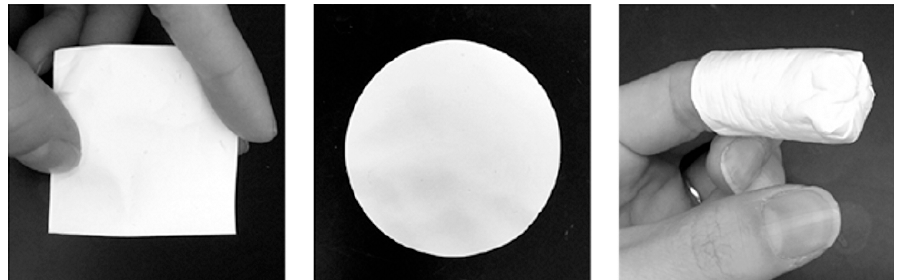
Figure 5. Examples of differently shaped, human sized PVA nanofiber mats (fiber cross-section diameter of ≈ 200–300 nm and mat thickness of 50–220 µ m according to Krogstad et al. [119]). Left —square (25 cm 2 ); center —circle (diameter = 5 cm); right —capped tube (length = 4 cm, diameter = 2 cm). Adapted from [118] under the terms of the Creative Commons Attribution License 4.0 (Copyright 2018 Laborde et al.; doi:10.1371/journal.pone.0204821).